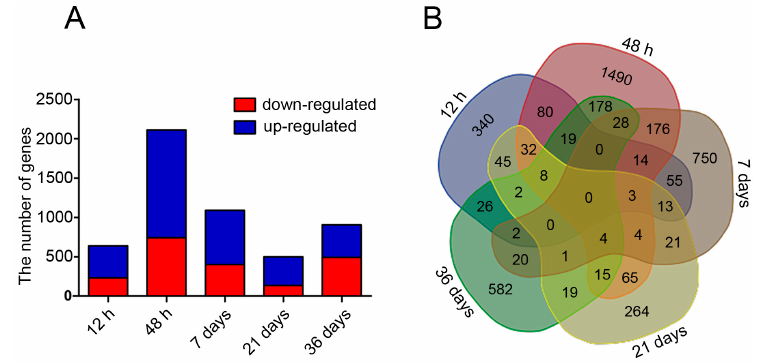
Figure 3. Changes in mRNA expression levels in H 2 -exposed PEMs. The histogram ( A ); and Venn diagram ( B ) show the number of DEGs at different time points.